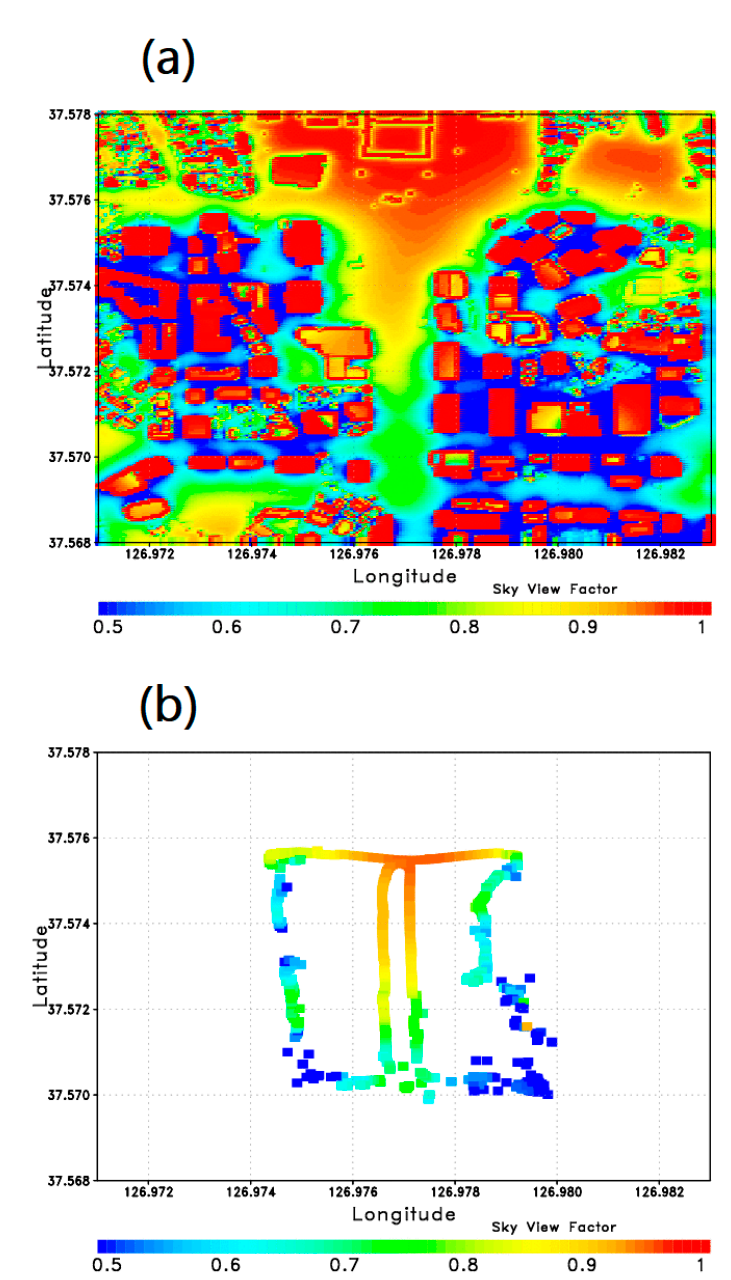
Figure 8. Sky view factor (SVF) distributions retrieved from digital surface model (DSM) ( a ) in the study area and ( b ) on the observation route of MOVE.